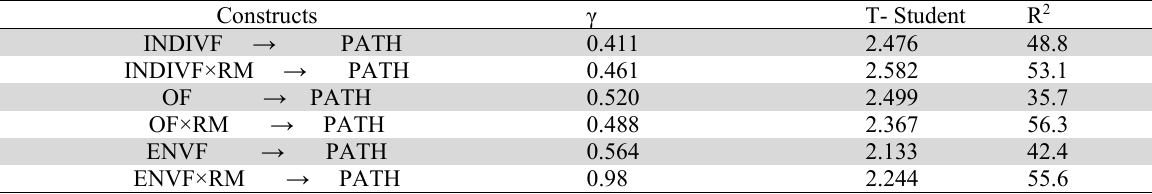
Results for structural model